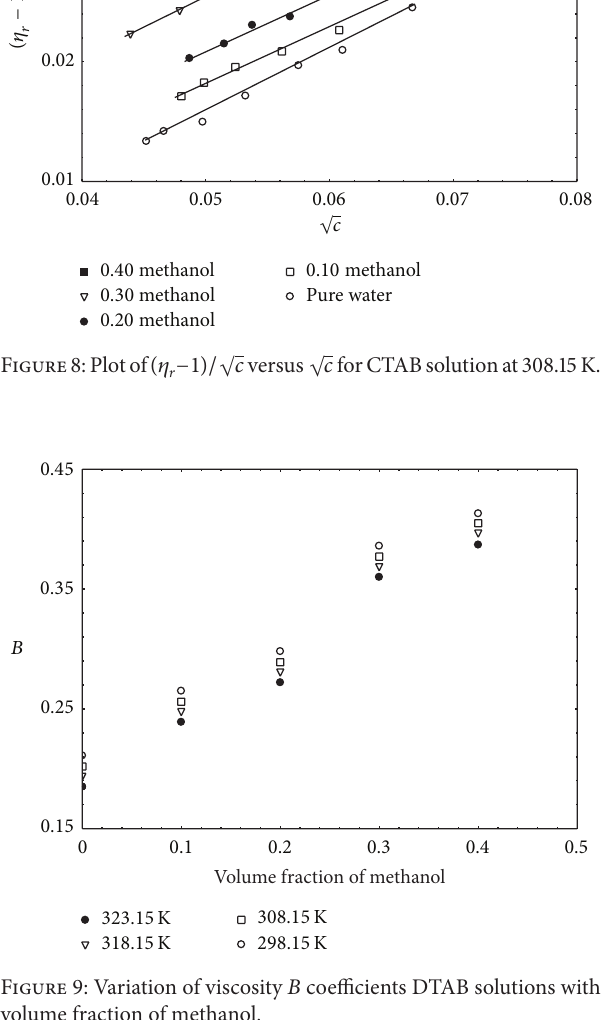
Figure 9: Variation of viscosity 𝐵 coefficients DTAB solutions with volume fraction of